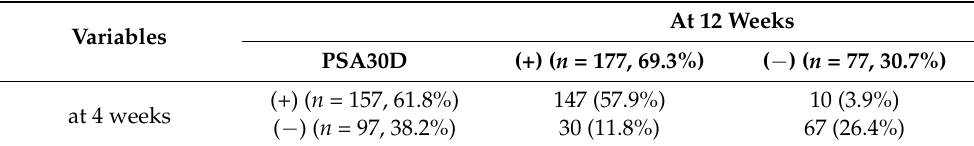
Table 3. Patient distribution according to >30% PSA decline (PAS30D) at 4 and 12 weeks from the initiation of first-line treatment using ASIs (AA or Enz) in 254 mCRPC